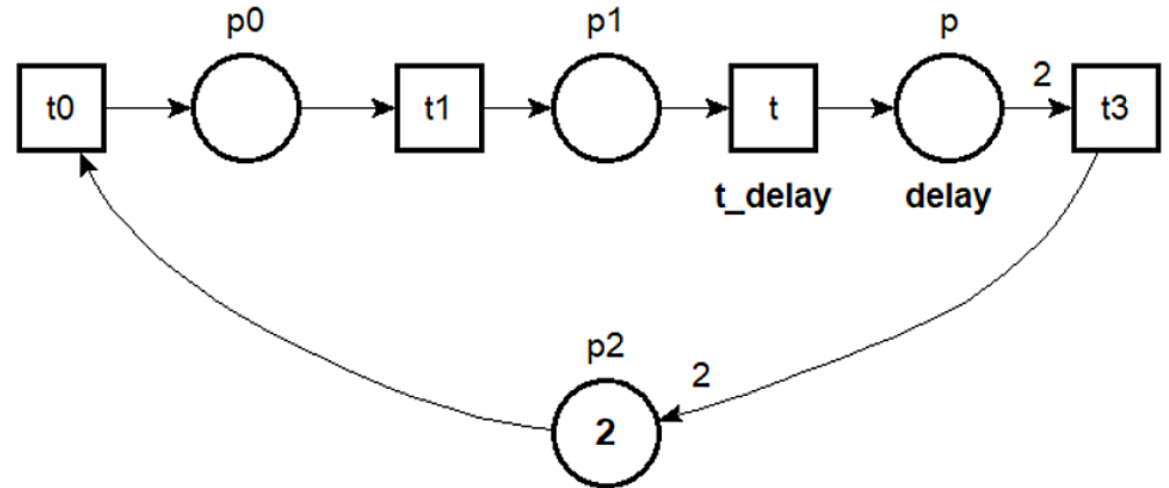
Figure 4. Resource analysis based on the time factor.